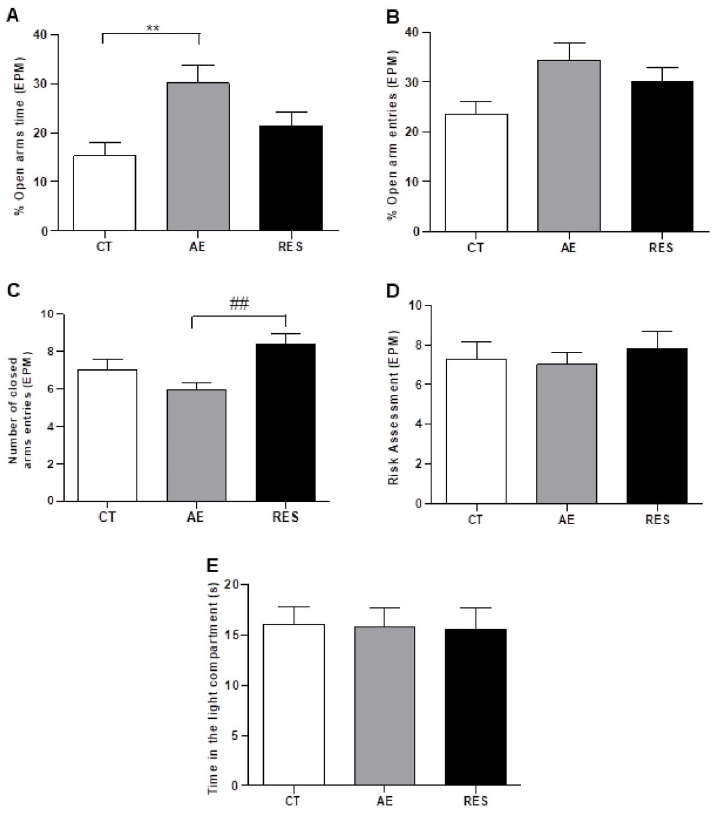
Figure 2. Anxiety-like behavior of rats in the elevated plus-maze (EPM) and light-dark box paradigms. A , Percentage of time spent in the open arms. B , Percentage of open arms entries. C , Number of closed arms entries. D , Number of risk assessments. E , Time spent in the light compartment. Data are reported as means ± SE (n=11 – 13 per group). **P o 0.01, ## P o 0.01, one-way ANOVA followed by Tukey ’ s post hoc . CT: sedentary control; AE: aerobic exercise on the treadmill; RES: resistance exercise on the ladder